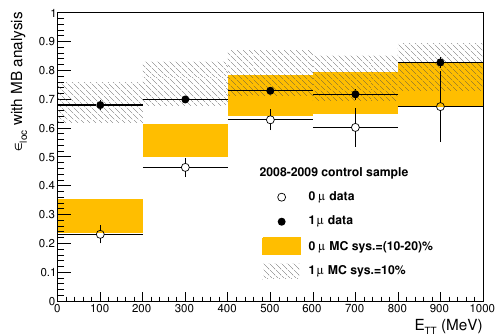
Figure 3. Location e ffi ciency as a function of the energy deposited in the TT for a control sample of data collected in 2008 and 2009 runs (bullets), compared with MC (histograms). Error bars and bands represent the statistical and systematical uncertainties in the data and in the MC,